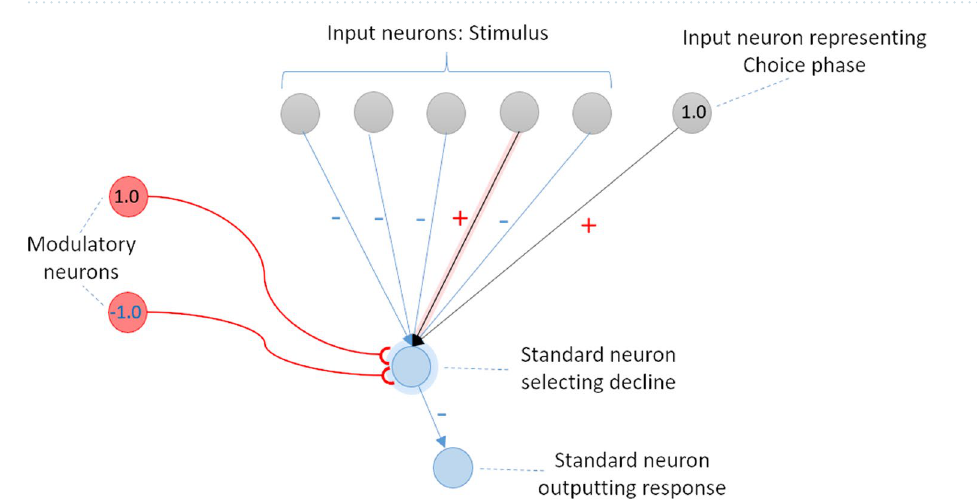
Figure 11. Main structure of an alternative first-order plasticity network capable of behaving like the evolved network. The network makes a metamemory judgment by directly using the result of a judgment whether the memory state exists or not without forming a